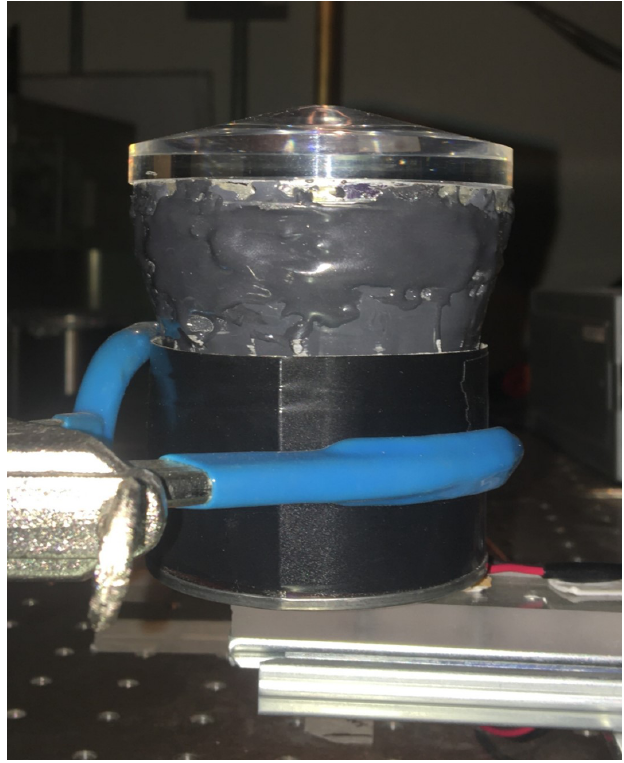
Figure 5. Lateral view of the system ready to be measured.